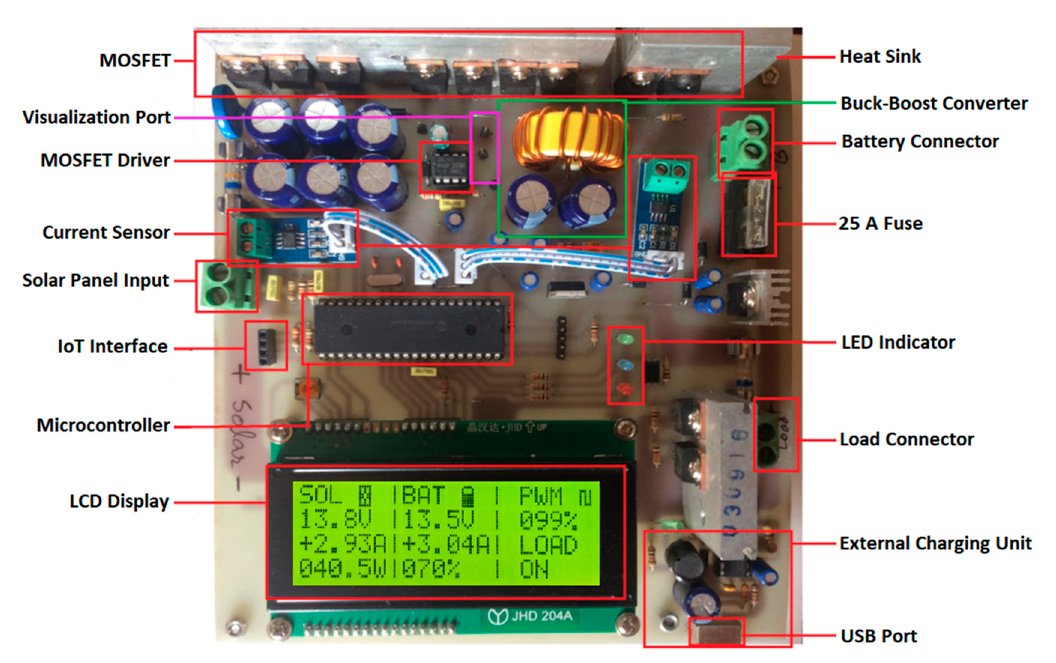
Figure 3. Proposed block diagram of the MPPT solar charge controller (SCC).